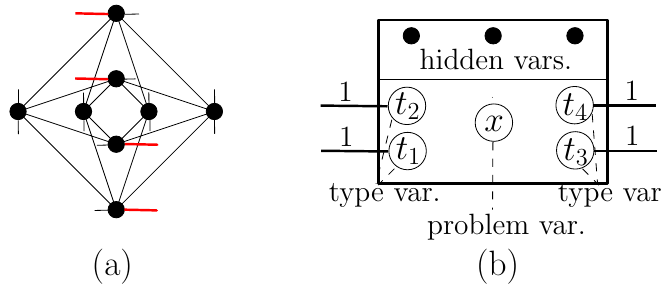
Figure 12. The structure of the tiles for the case of gap = 4. ( a ) A cell of the Chimera graph. Short lines indicate the couplers connecting to the neighboring cells. ( b ) The logical structure of the tile corresponding to that cell. Edges correspond to couplers shown in red in ( a